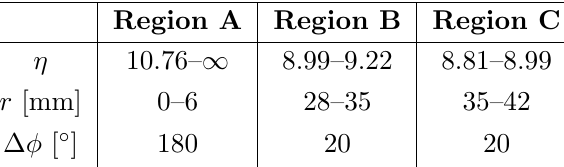
area (more details are given in table 2). Due to the limited position resolution of the imaging layers, a small migration of events inside and outside the pseudorapidity regions is present. This e(cid:11)ect is taken into account both by including it in the fake and missed events correction factors and by adding a position resolution systematic